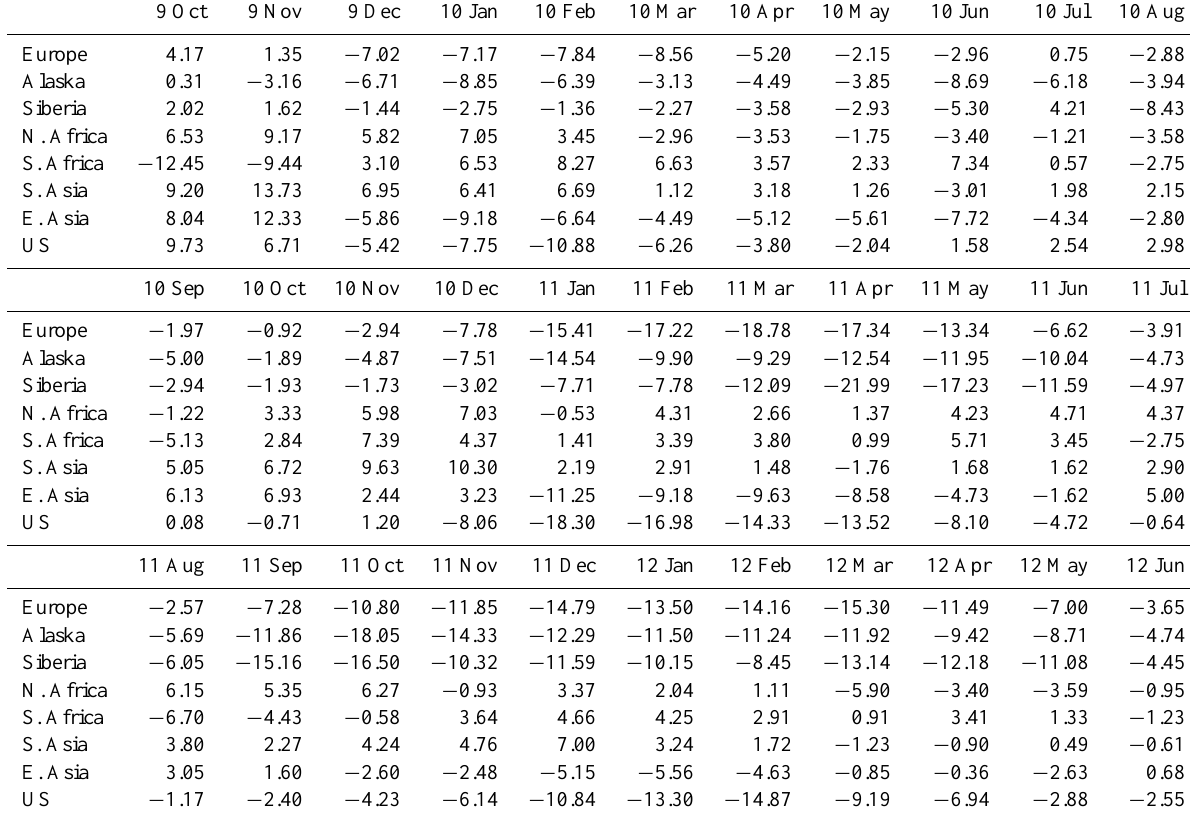
Table 6. Modified normalised mean bias (MNMB) [%] derived from CO satellite observations (MOPITT) and the MACC_osuite simulations of CO total columns from October 2009 until June 2012 averaged over different